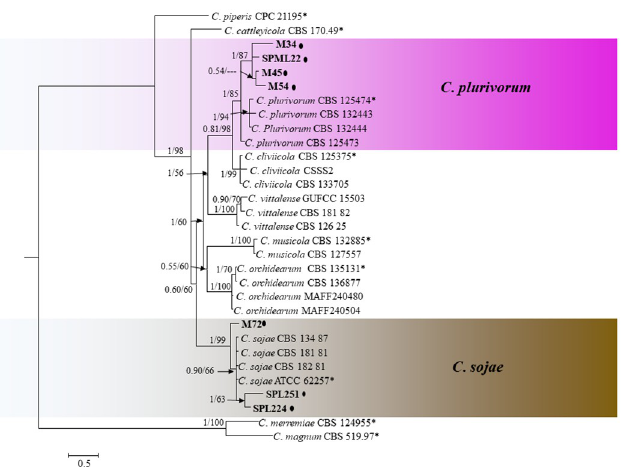
Fig 5. A Bayesian inference phylogenetic tree (50% majority consensus) of 31 isolates in the C . orchidearum species complex. The tree is rooted with C . merremiae (CBS 124955) and C . magnum (CBS 51997). The tree was constructed using a concatenated data set of ITS, ACT , TUB2 , CHS-1 and GAPDH sequences. Bayesian posterior probability (PP � 0.50) and maximum likelihood bootstrap support values (ML � 50) are shown at the nodes. � Indicates the ex-type strains. The isolates collected in this study are indicated in bold. Coloured blocks indicate clades containing isolates from Atractylodes ovata in this study. The scale bar indicates 0.5 expected changes per site.